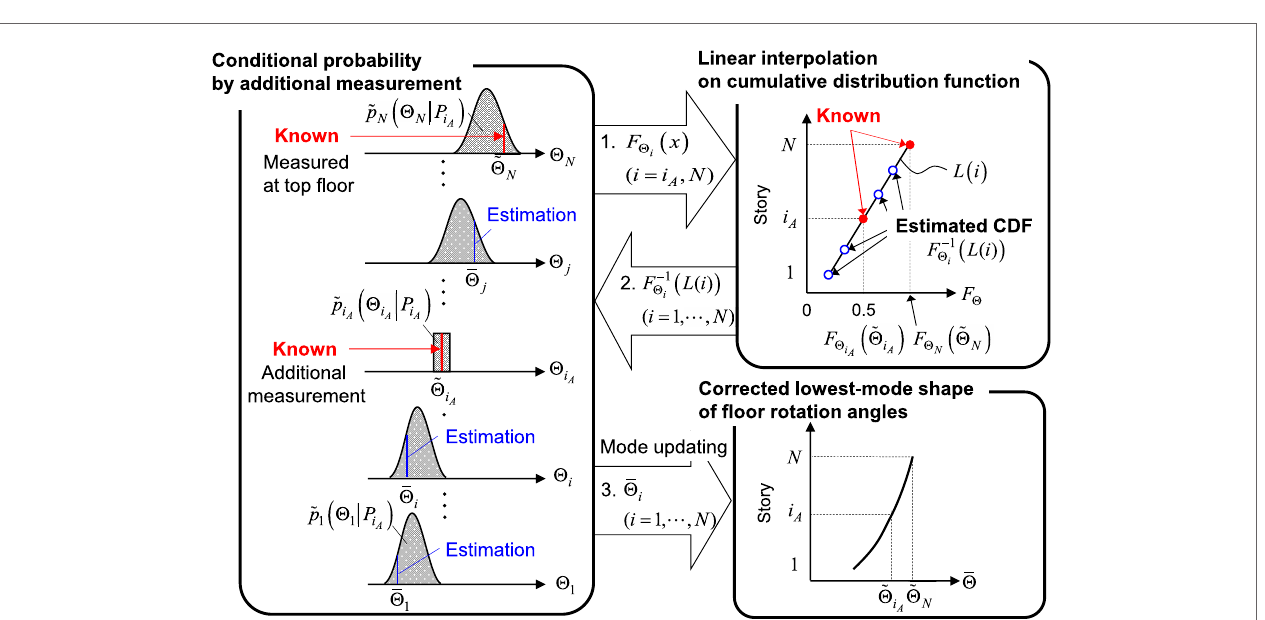
FIGURE 4 | Estimation of floor rotation angles in lowest mode by linear interpolation on cumulative distribution function